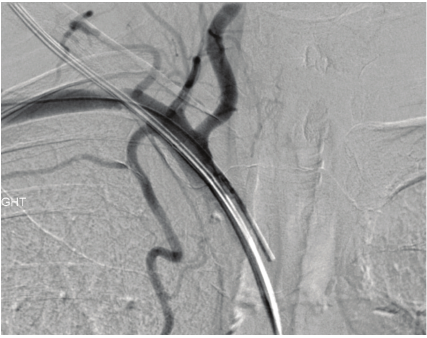
Figure 3: Catheter angiogram showing relation of catheter site to the right vertebral artery.